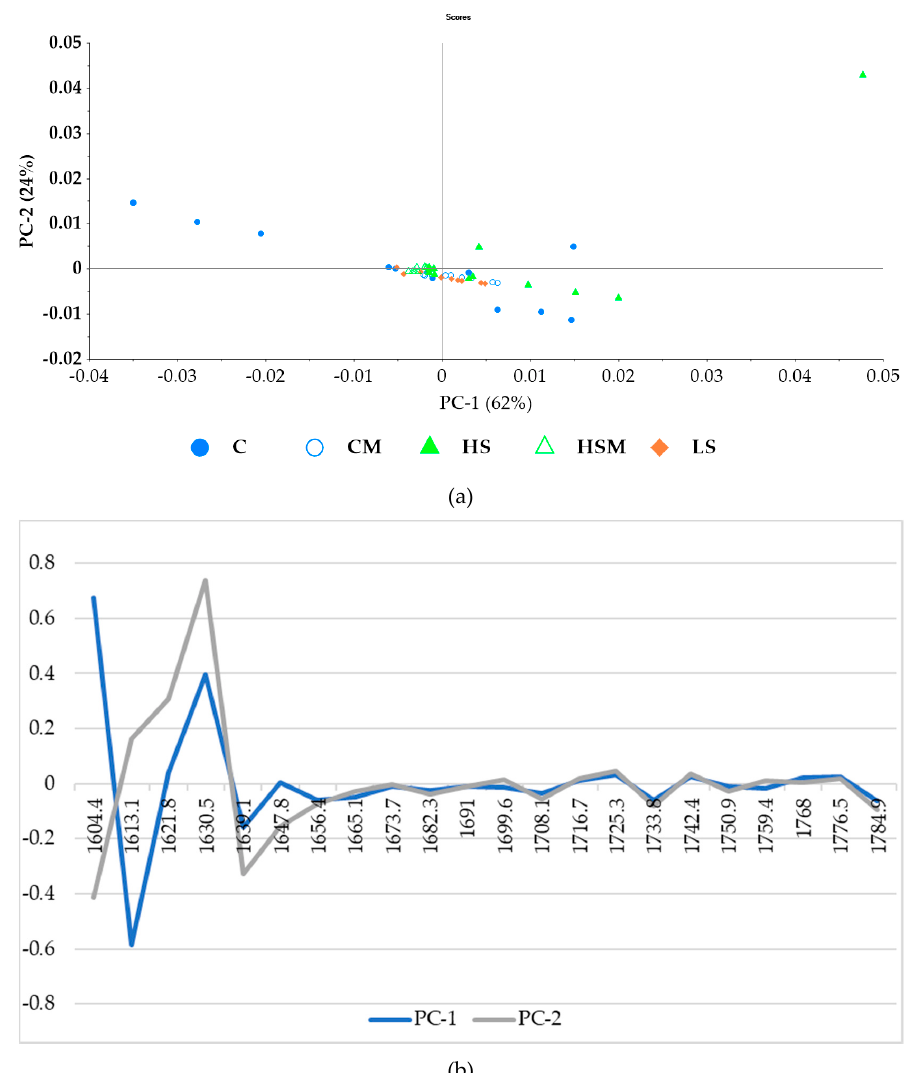
Figure 5. Principal component analysis (PCA) for the microPHAZIR TM leaf absorbance values between 1600–1800 nm ( a ) and loadings ( b ). Abbreviations: C = control without misting; CM = control with misting; HS = high density smoke without misting; HSM = high density smoke with misting; and LS = low density smoke.